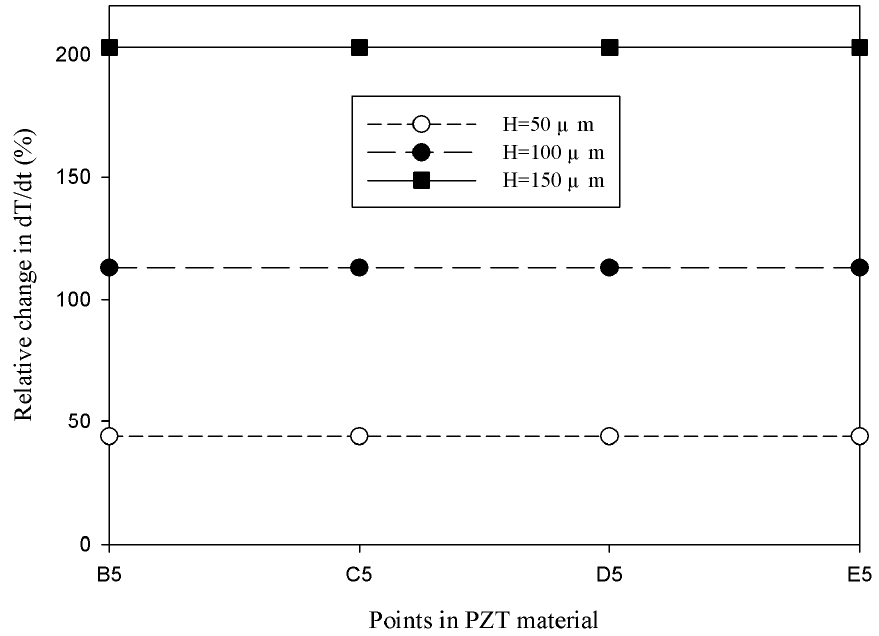
Figure 13. Simulated relative change in the maximum peak value of the temperature variation rate at points B5, C5, D5 and E5 for the mesh top electrode with cavities in the PZT material, compared with that at point A5 for the fully covered electrode, with an electrode width of 100 μ m and etching depths of 50, 100 and 150 μ m.